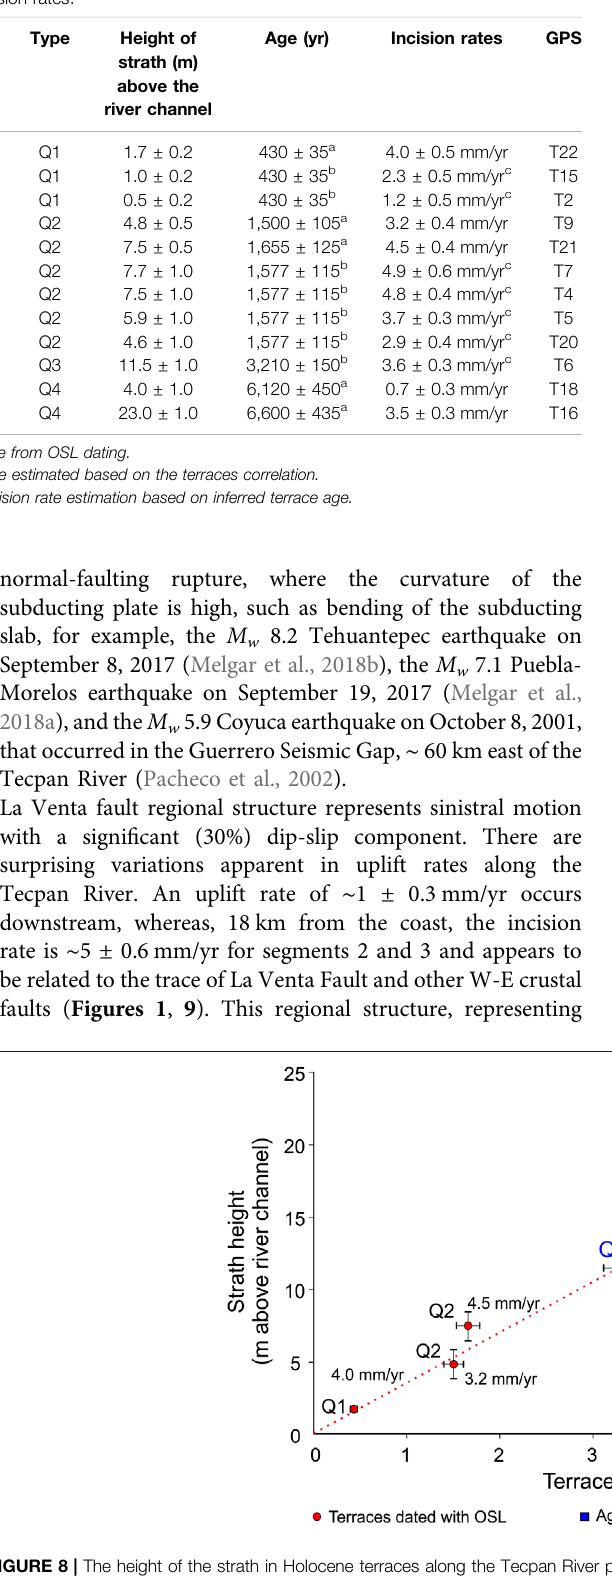
Frontiers in Earth Science |